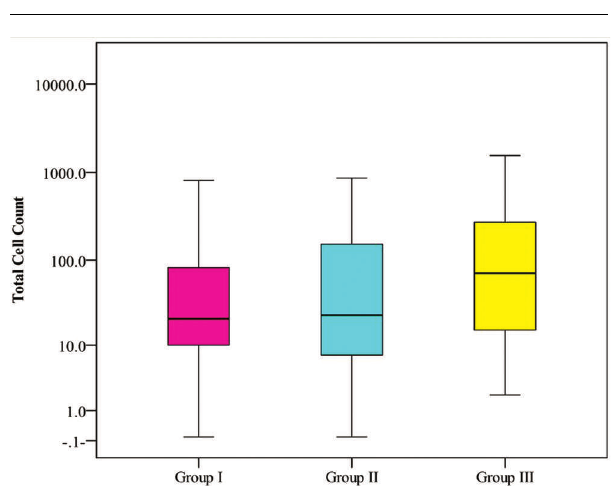
Comparison between the three groups according to total cell count (cell/cm 3